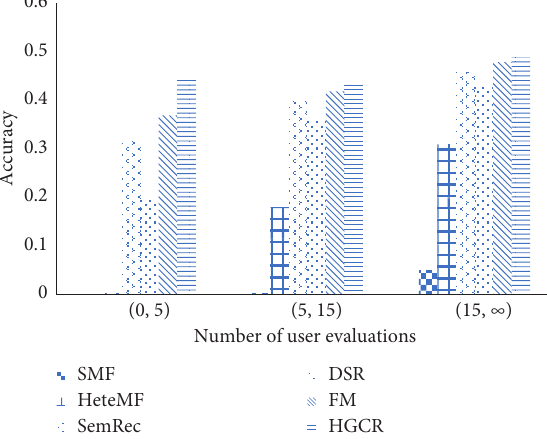
Figure 9: Performance of cold start on Yelp.